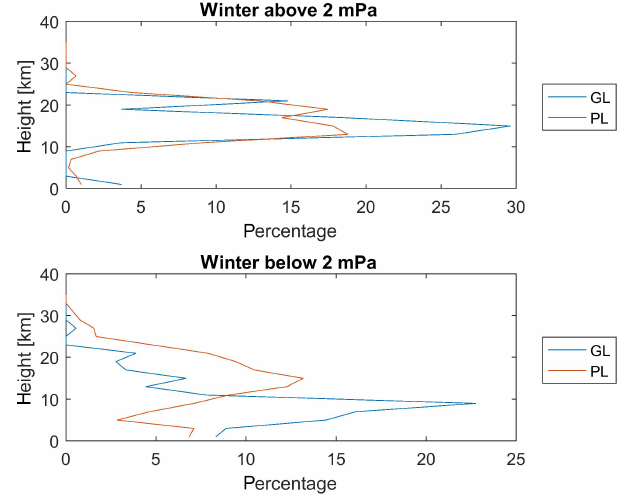
Figure 11. The same as Fig. 9 but in